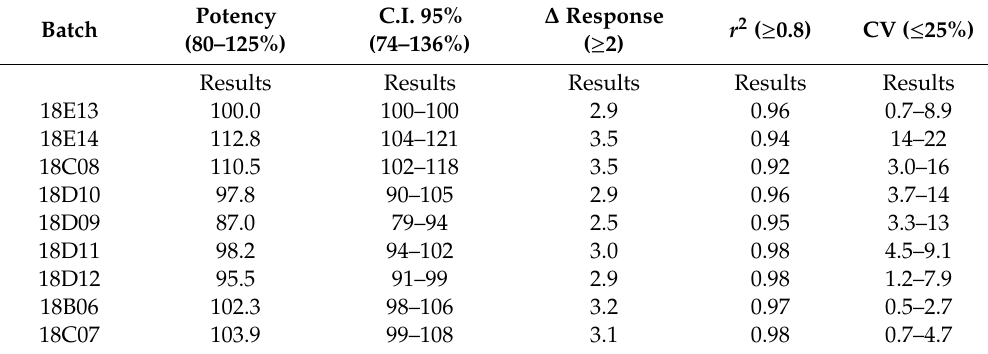
Table 2. Results of the parameters determined during the evaluation of eight batches of Transferon ® for system